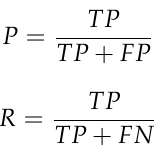
Table 3. Experimental environment configuration.